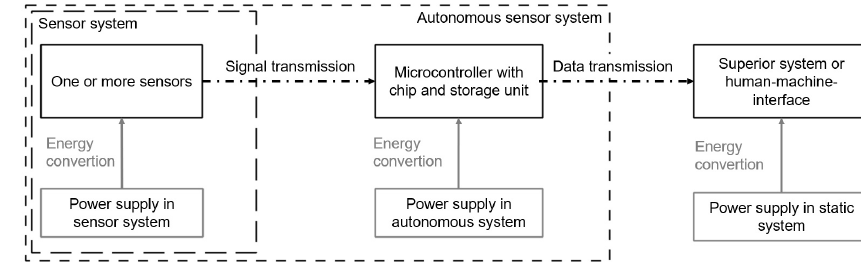
Figure 1. Definition of an autonomous sensor